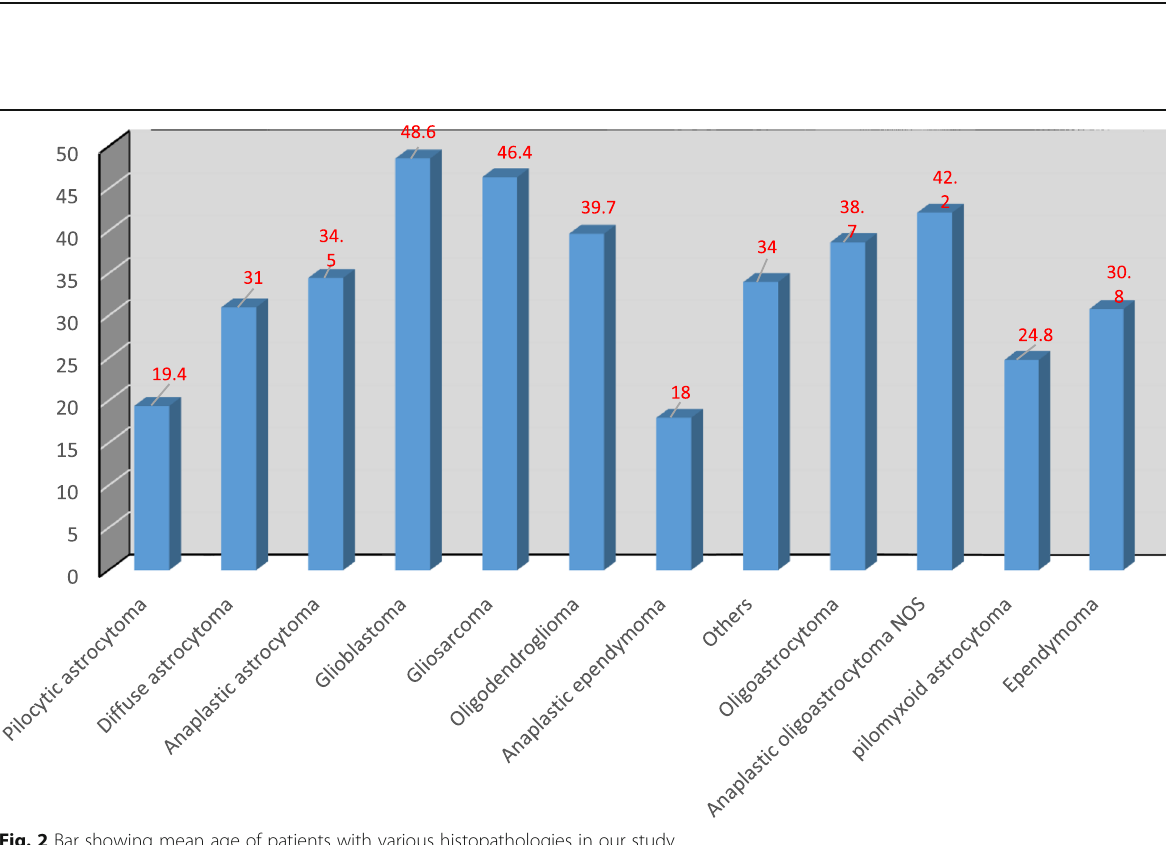
Fig. 1 Relation of WHO grade of tumors with age of patients in our study. The higher grade tumors presented at elder age (mean 48.47) as compared to low grade tumors (who presented at mean age of 20.68)